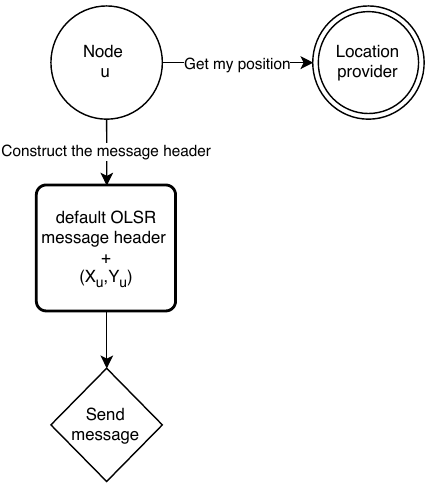
Figure 7. Location service in